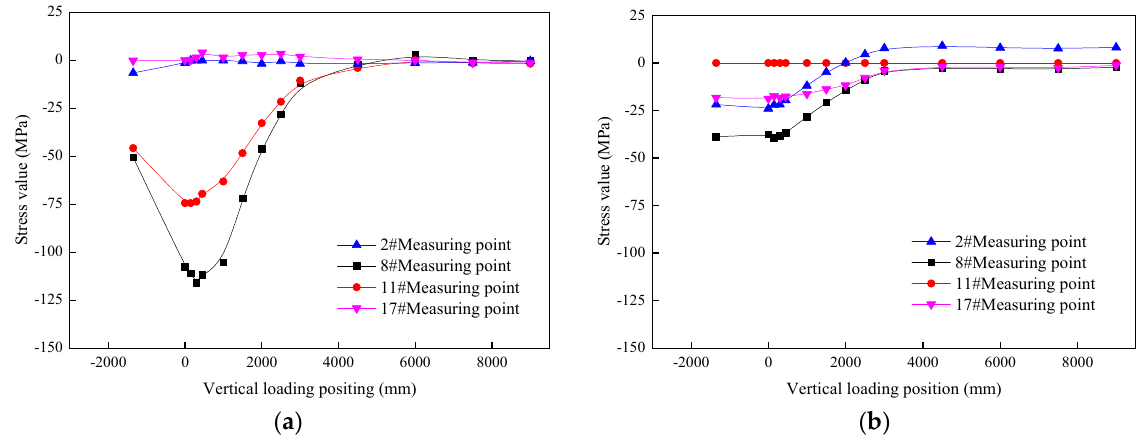
Figure 13. Longitudinal loading 96# diaphragm (unreinforced) CI area measuring point stress-load position relationship curve: ( a ) The first CI area, ( b ) the second CI area. ② The stress curve of the 100# cross-sectional plate reinforced by “arc-cut optimization + steel plate reinforcement” is shown in Figure 14. The peak stress before reinforcement is about − 120 MPa, and the peak stress after reinforcement is about − 39 MPa, with a reduction of 67.5%. It indicates that this reinforcement method can effectively reduce the stress amplitude in the crack sprouting area at the curved cutout and improve the fatigue life. Moreover, the stress changes in measurement point 8# and 11# directly below the wheel load after reinforcement were more obvious, with a significant reduction in the peak stress curve and a significant flattening of the curve change. However, the stress curves of measurement points #2 and #17 did not show significant changes before and after reinforcement.